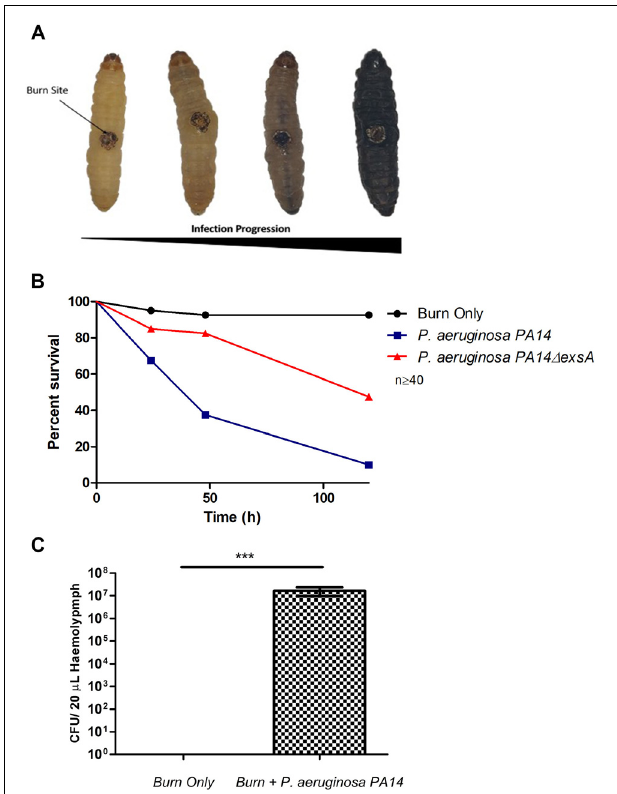
FIGURE 3 | Visualization of burn wound pathogenicity over time: (A) Following the burn wound procedure and subsequent infection, the tissue at site of the burn will turn necrotic and evidence of bacterial dissemination is seen through the melanization of the larvae and loss of motility. Representative images of each stage shown. (B) Percentage survival of larvae after infecting the burn site with PA14 (cid:49) exsA which has an inactive T3SS and Wild Type PA14 against the uninfected control group burn. PA14 vs Burn Only Log Rank p < 0.001, Burn Only vs PA14 (cid:49) exsA Log Rank p < 0.001, PA14 (cid:49) exsA vs Burn Only Log Rank p < 0.001. n ≥ 40 per condition. (C) Hemolymph (larval blood) was aspirated and the bacterial numbers enumerated by plating serial dilutions n = 25 larvae, with SEM. Mann–Whitney U -test *** p <